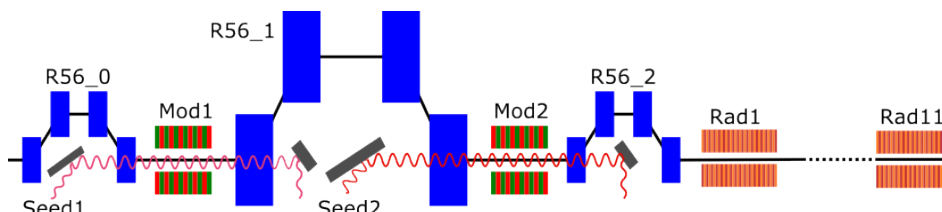
Figure 3. Layout of the seeding beamline (side view). Seed laser 1 (Seed1) is injected using the in coupling chicane (R56_0), while seed laser 2 (Seed2) uses the overshearing chicane (R56_1). Bunching chicane (R56_2) is used to convert the energy modulation produced by the two lasers in the two modulators (Mod1,2) into bunching before the beam enters the final radiator (Rad1, ...).